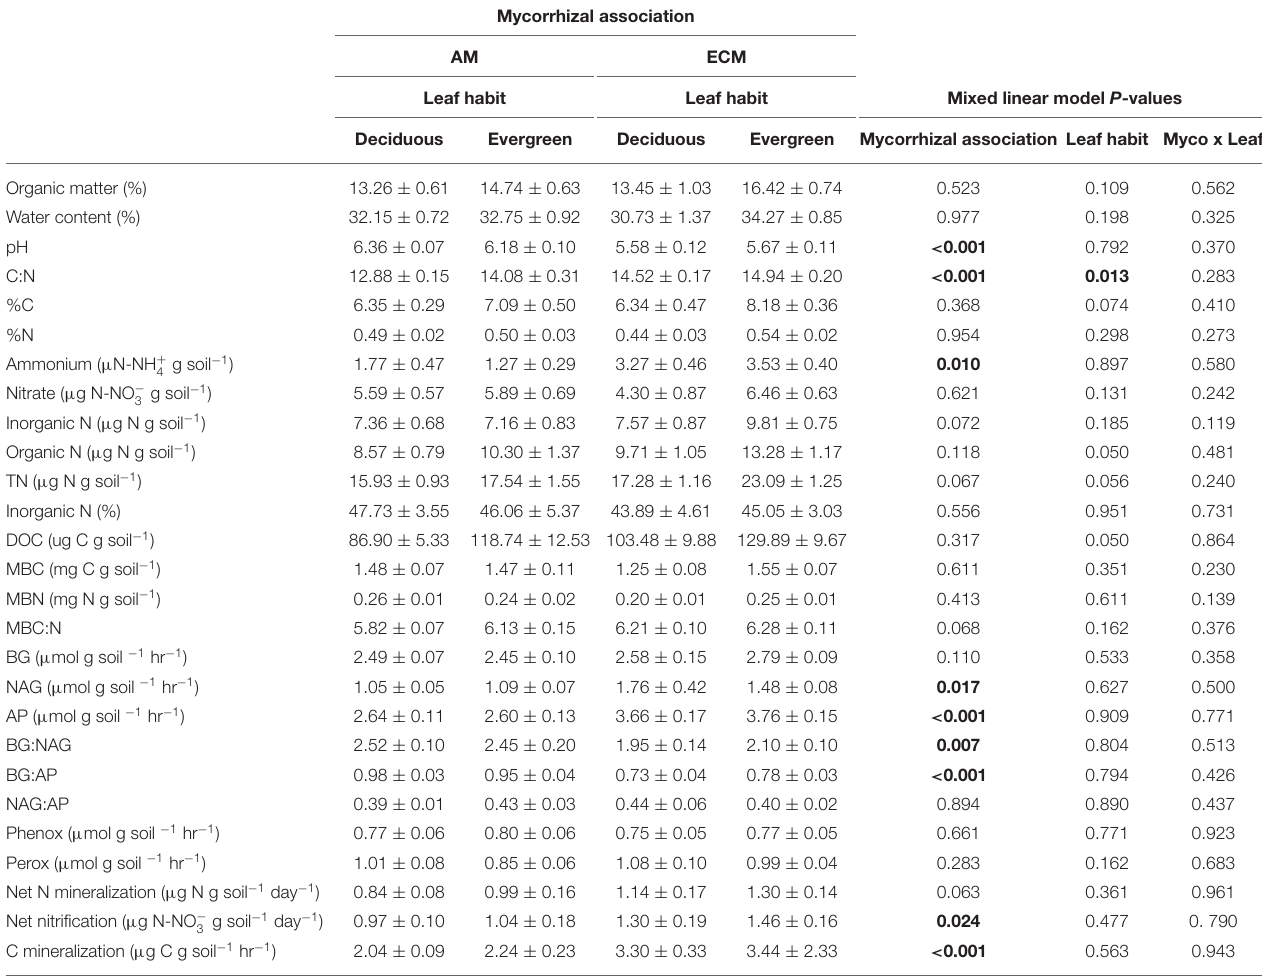
TABLE 2 | Properties of 0–5cm soils in AM deciduous, AM evergreen, ECM deciduous, and ECM evergreen forestry plots at The Morton